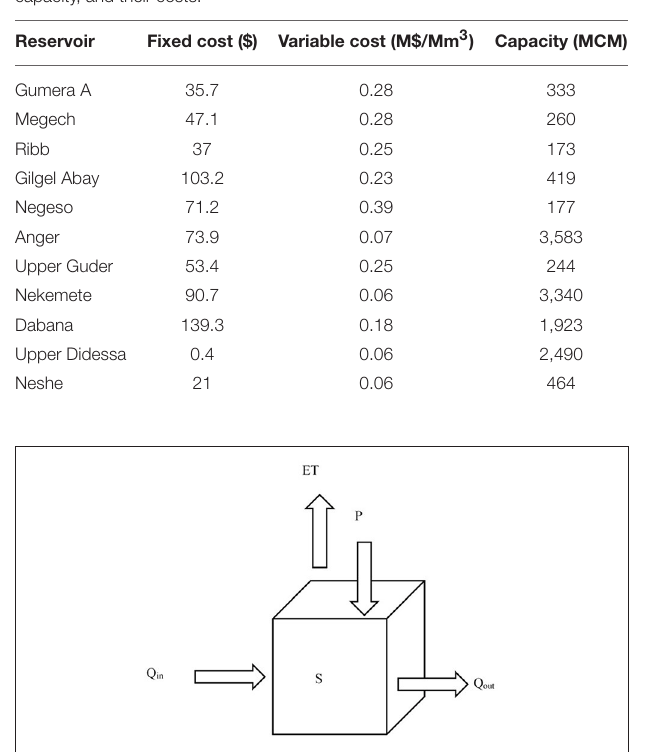
FIGURE 1 | A schematic diagram of a typical grid cell with hydrologic variables used in the data assimilation procedure.